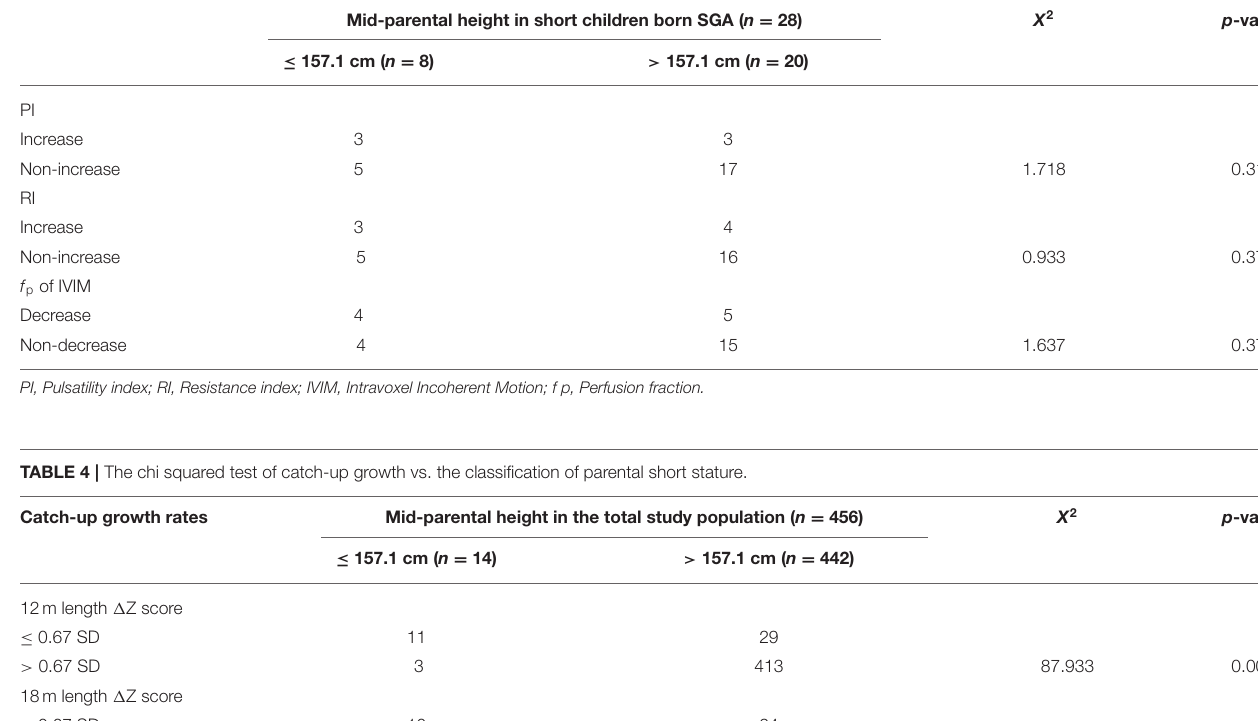
TABLE 3 | The chi squared test of mid-parental height against pulsatility index (PI), resistivity index (RI), or intravoxel incoherent motion (IVIM) measures.